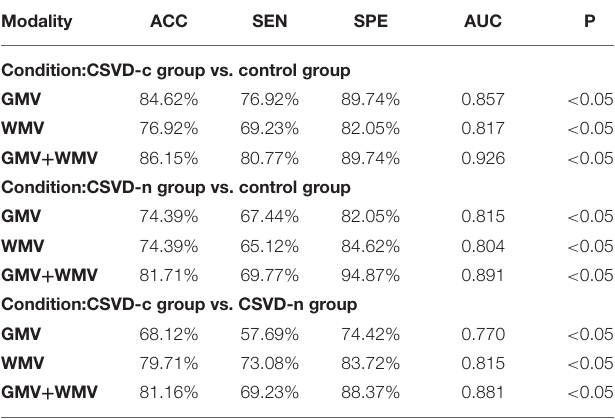
TABLE 3 | The statistics for evaluating classification